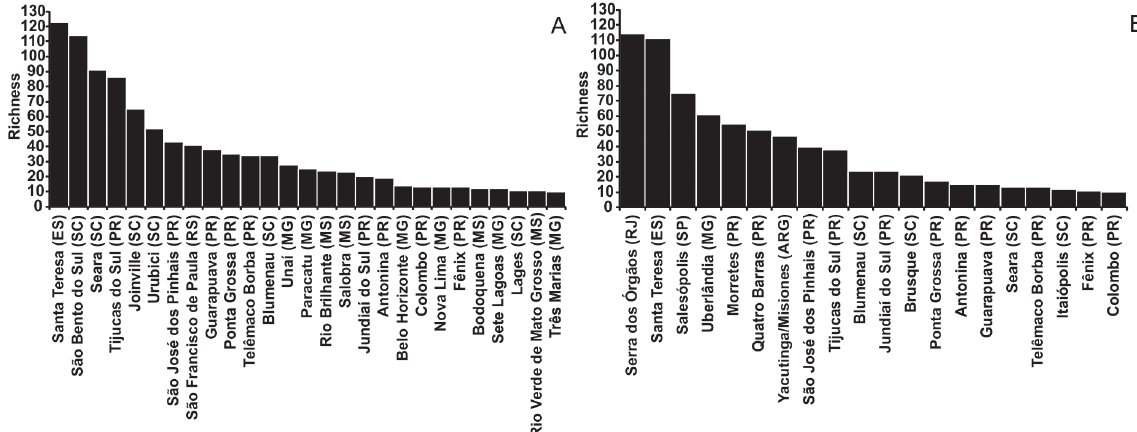
Figure 4 - Richness of Saturniidae (A) and Sphingidae (B) compared between different